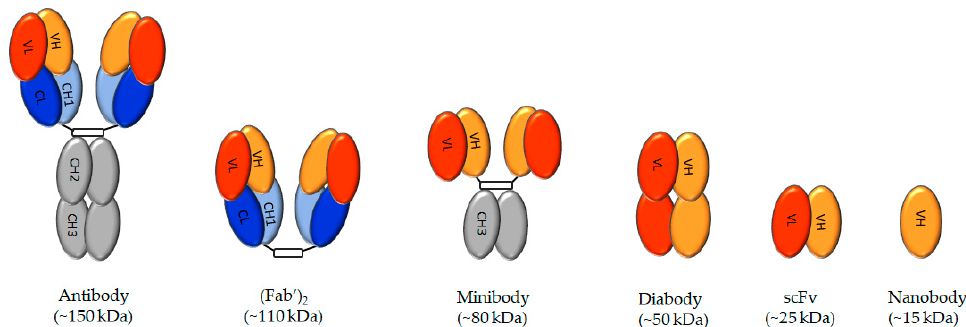
Figure 2. Schematic representation of antibody-based molecules. VH—heavy chain variable region, VL—light-chain variable region, CL—light-chain constant region, CH—high chain constant region 1, CH2—high chain constant region 2. CH3—high chain constant region 3.